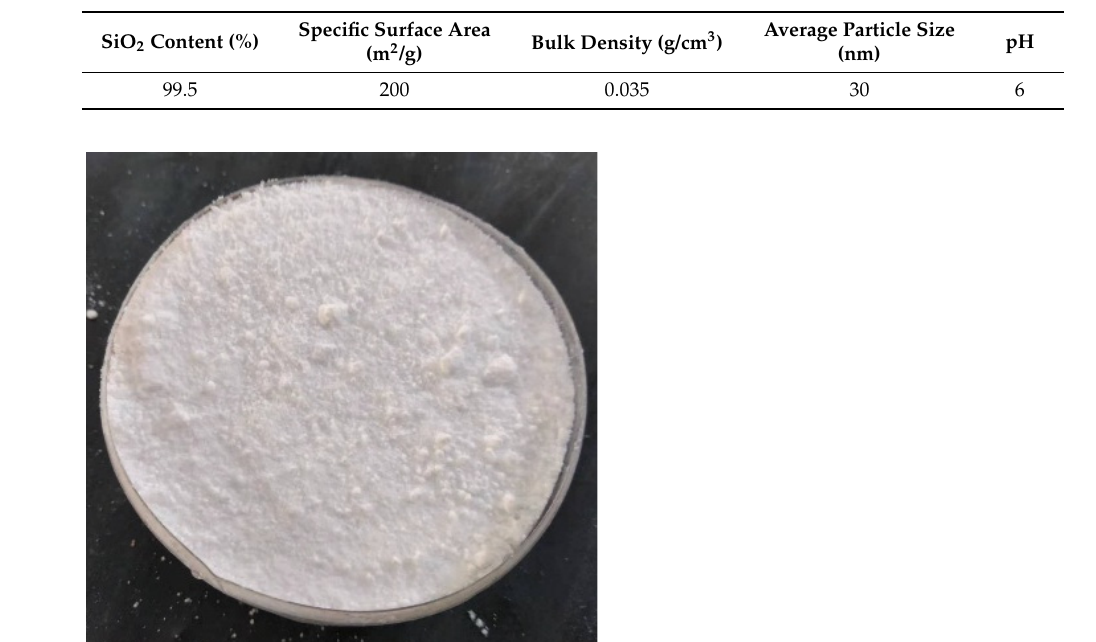
Table 4. The physical properties of NS.